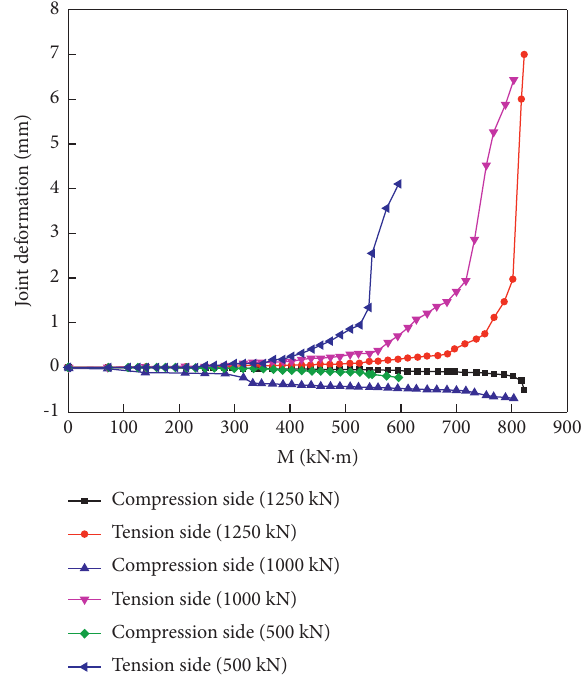
Figure 13: Deformation development of double-tenon joints with auxiliary pretightening device on the tension